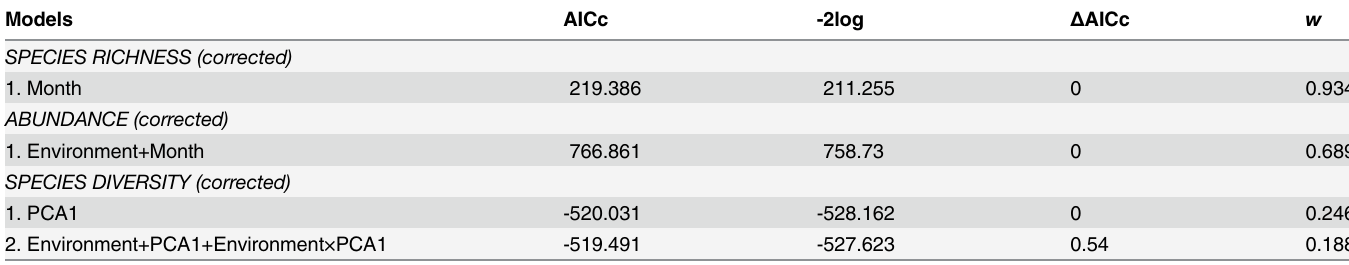
Table 2. Best generalized linear mixed models (GLMM) describing species richness, abundance and species diversity of birds in rural and urban areas during winter. Models